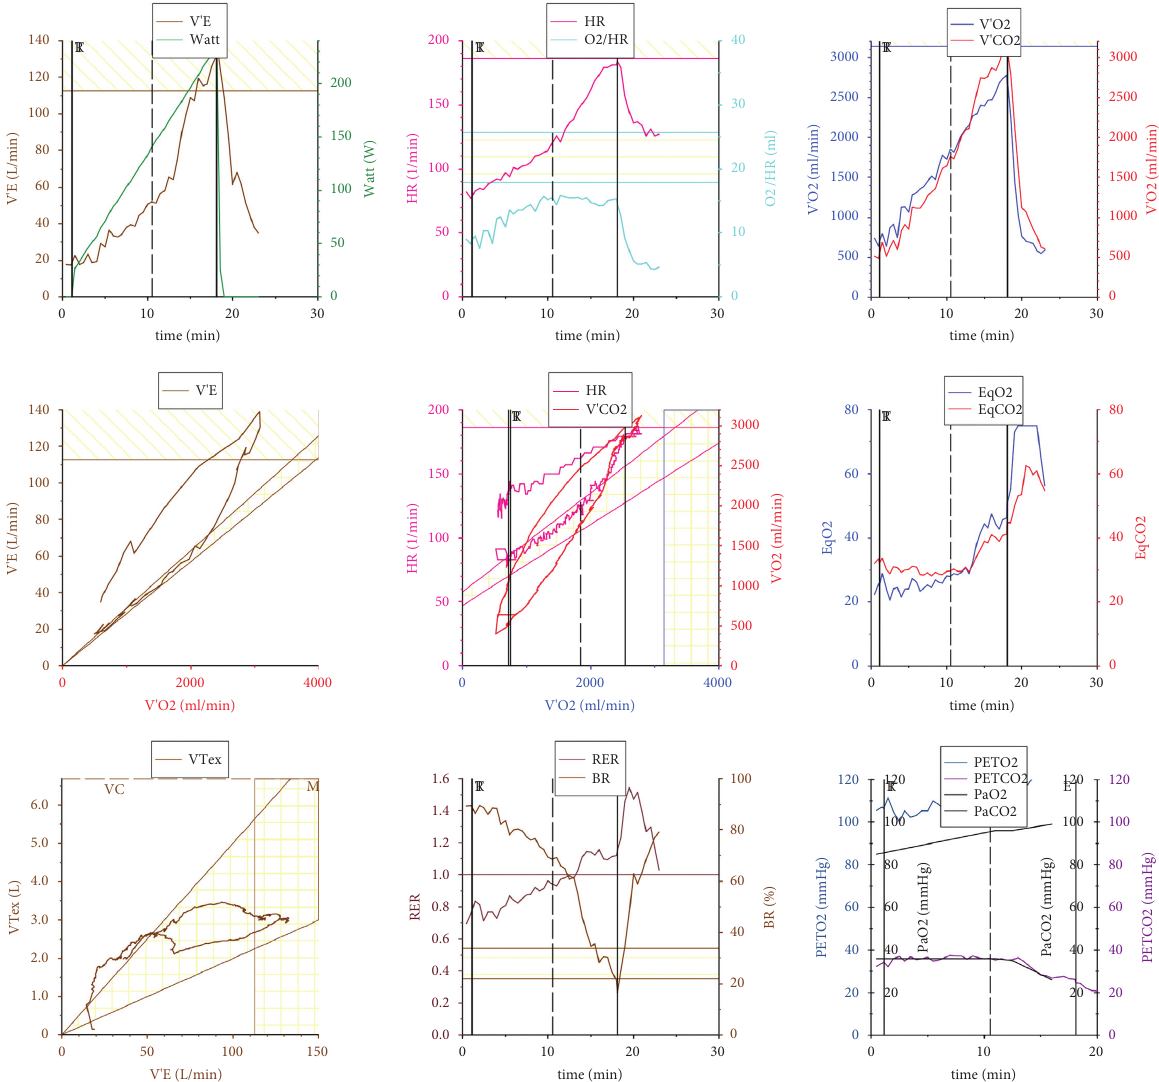
Figure 1: Representative 9-panel display of Wasserman of a limited post-COVID-19 patient. V’E: respiratory minute volume, HR: heart rate, O 2 /HR: oxygen pulse, V’O 2 : oxygen uptake capacity, V’CO 2 : carbon dioxide elimination capacity/carbon dioxide output, EqO 2 : oxygen ventilatory equivalents, EqCO 2 : carbon dioxide ventilatory equivalents, VTex: expiratory tidal volume, RER: respiratory exchange rate, BR: breathing reserve, PETO 2 : end-tidal partial pressure of oxygen, PETCO 2 : end-tidal partial pressure of carbon dioxide, PaO 2 : arterial/ arterialized capillary oxygen partial pressure, and PaCO 2 : arterial/arterialized capillary carbon dioxide partial